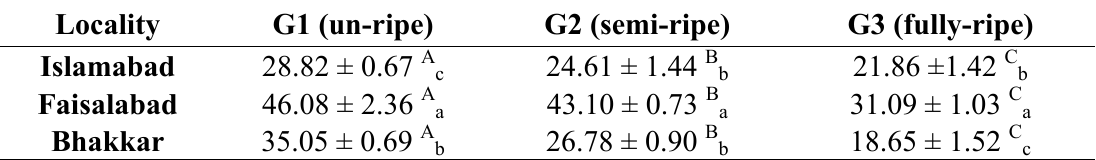
Table 3. Total flavonoid contents (mg CE 100 g − 1 dry wt.) of extracts from guava fruit collected at different stages of